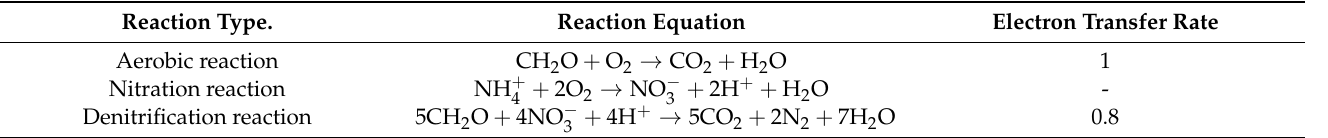
Table 1. The reaction equations used in the